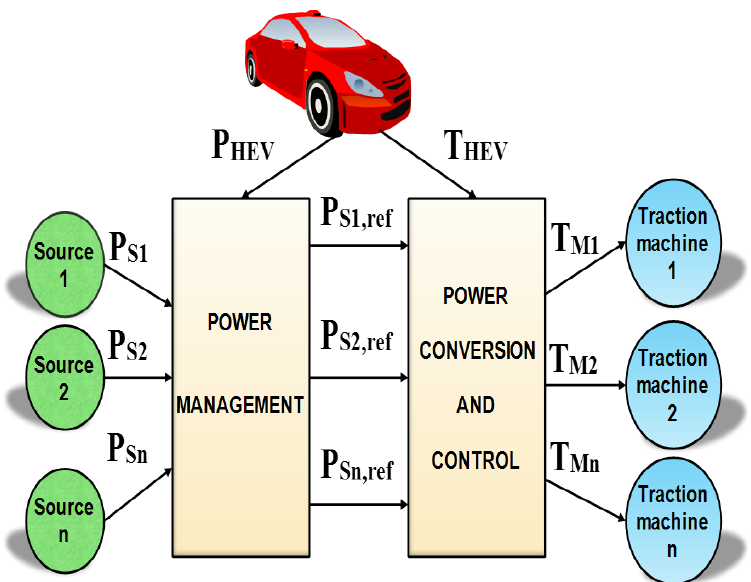
Figure 1. Classical abrupt switching.